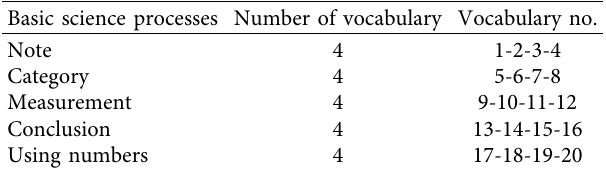
Table 7: Distribution of vocabulary test for basic science processes. Basic science processes Number of vocabulary Vocabulary no.